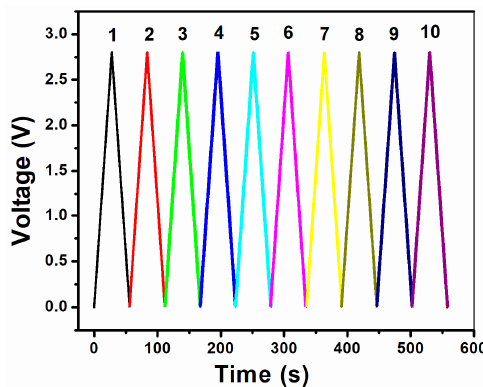
Figure 5. Galvanostatic charge/discharge curve of TiO 2 nanotube arrays at 100 µA/cm 2 .